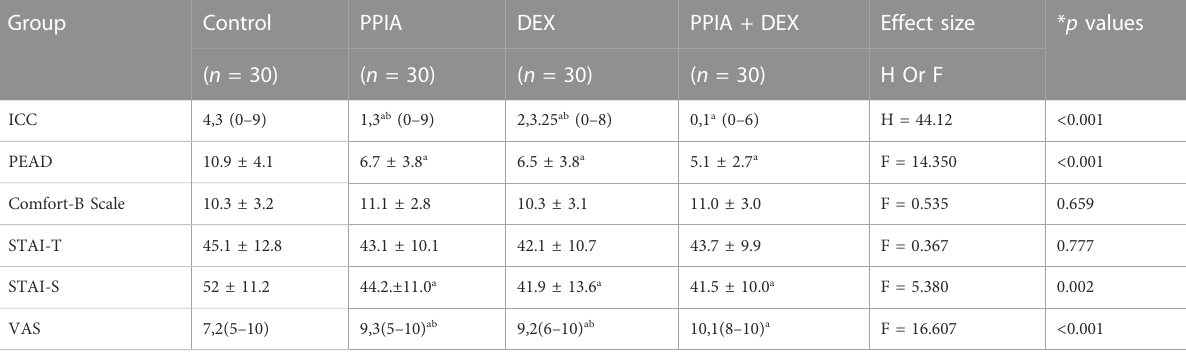
TABLE 3 Secondary outcome measures.